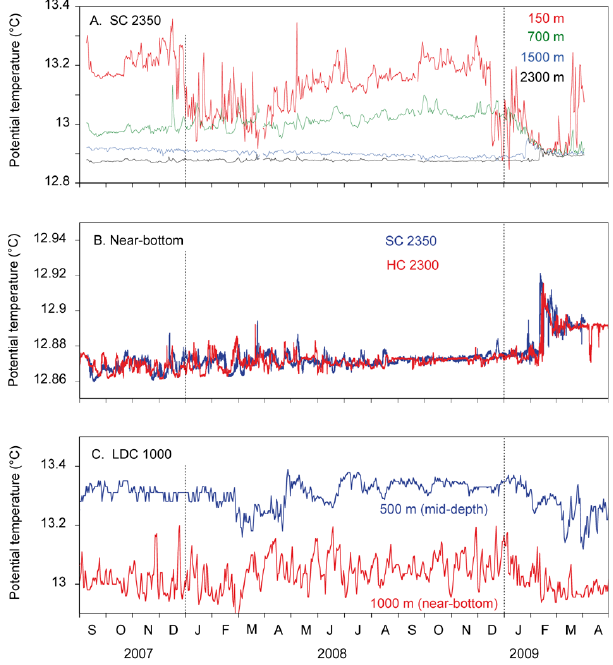
Fig. 5. Time series of (A) potential temperature at the LDC1000 site, (B) potential temperature at 150, 700, 1500 and 2300m nomi- nal depths at the SC2350 site, and (C) near-bottom potential temper- ature at SC2350 and HC2300 sites from September 2007 to April